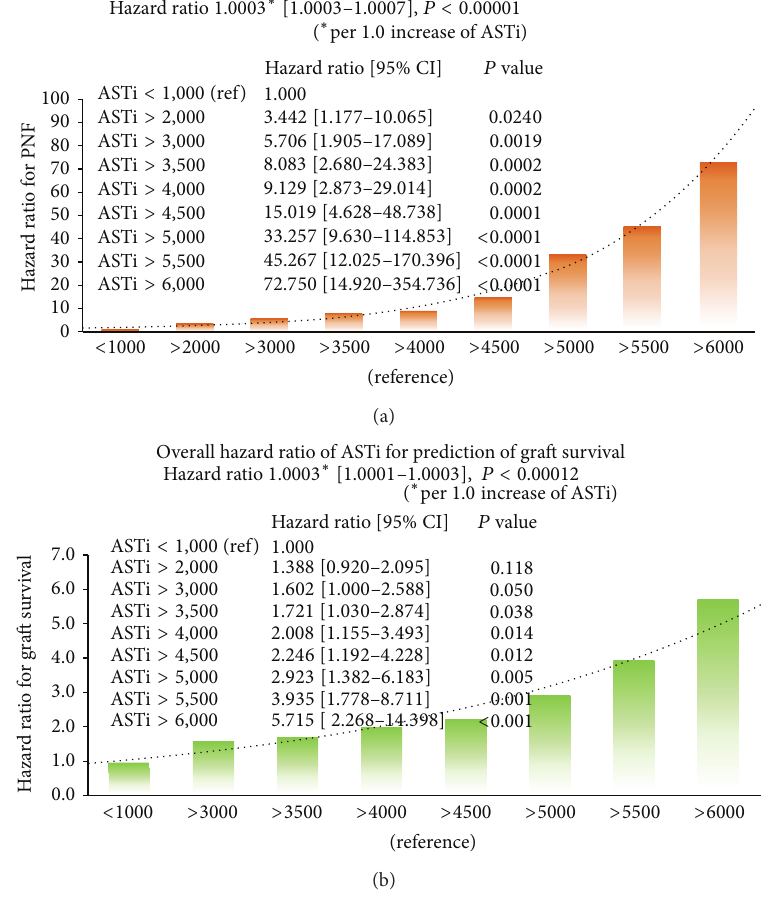
Figure 3: Predictive value of ASTi for primary nonfunction and one-year graft survival. (a) A logistic regression model showed that ASTi has significant impact on PNF (hazard ratio 1.0003 (95% CI: 1.0003–1.0007), 𝑃 = 0.00001 ). If ASTi is greater than 2,000 IU/L, there is an exponentialincreaseofhazardratioforPNFalongwithincreasedASTi.(b)ACoxproportionalhazardmodelshowedthatASTihassignificant impact on graft survival (hazard ratio 1.0002 (95% CI: 1.0001–1.0003), 𝑃 = 0.00012 ). If ASTi is greater than 3,500 IU/L, there is an exponential increase of hazard ratio for PNF along with increased